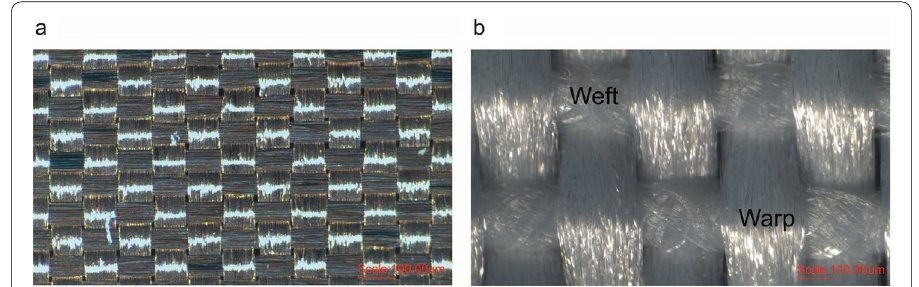
Fig. 2 Optical images of the a conductive (copper-plated) polyester and b dielectric polyester